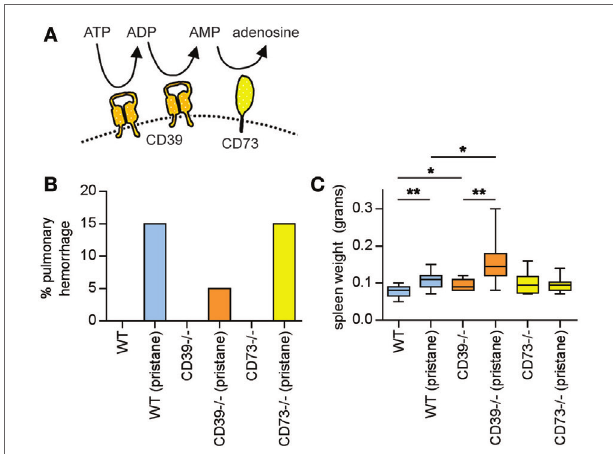
FigUre 1 | Pulmonary hemorrhage and splenomegaly in pristane-treated mice. (a) Schematic of CD39 and CD73, which together mediate the step-wise phosphohydrolysis of extracellular ATP into adenosine. (B) Some mice developed clinically overt pulmonary hemorrhage within the first month after pristane administration; these mice required euthanasia. N = 10 saline-treated mice and 20 pristane-treated mice per genotype; no comparisons were statistically significant. (c) Mice were administered either saline or pristane, as indicated. 36 weeks later, spleen size was measured. N = 10 per control group and 17–19 per pristane group; * p < 0.05 and ** p < 0.01. Box-and-whisker plots denote minimum, 25th percentile, median, 75th percentile, and